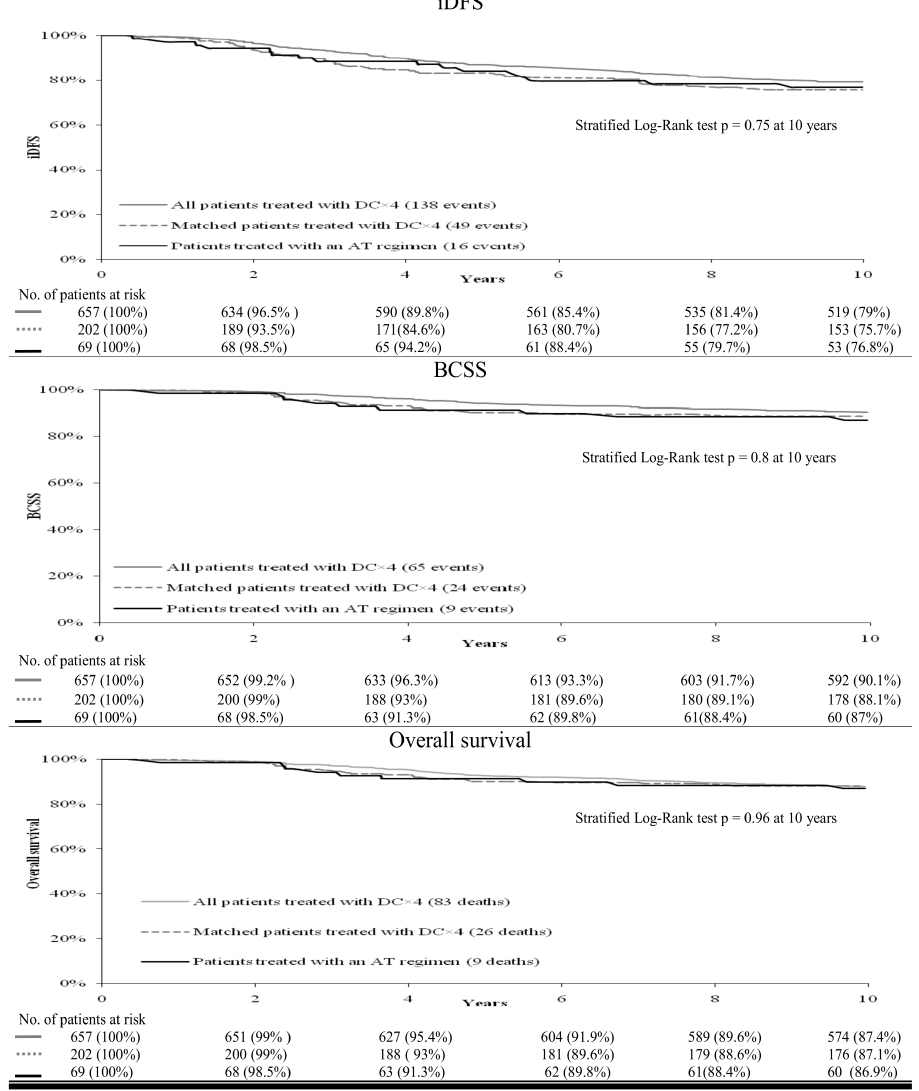
Figure 1. Analyses comparing patients treated with DC4 to patients treated with